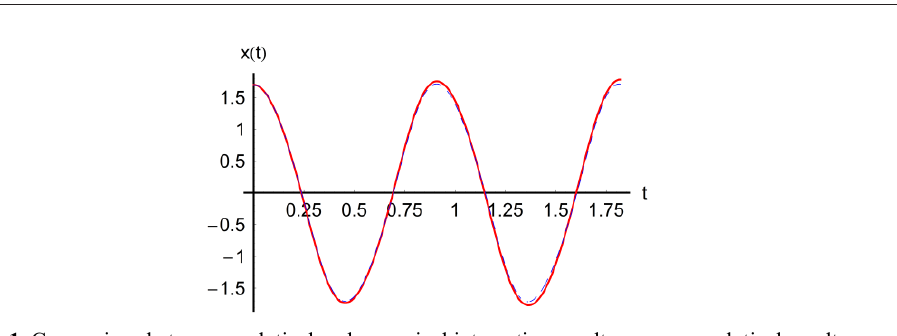
Fig. 1. Comparison between analytical and numerical integration results: _ _ _ _ analytical results; _______ fourth-order RK